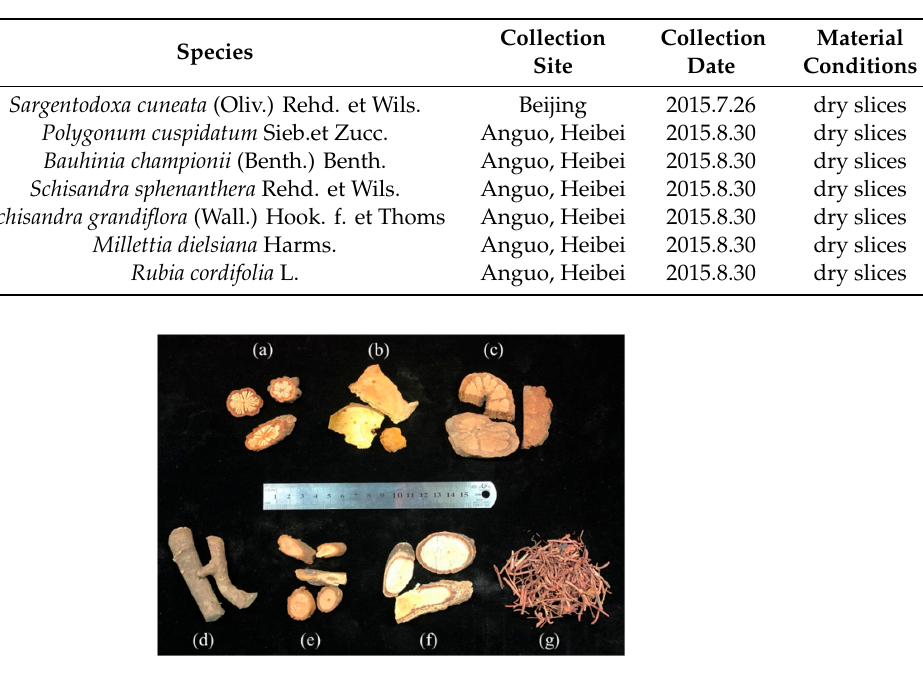
Figure 6. Herb configurations: S. cuneata ( a ), P. cuspidatum ( b ), B. championii ( c ), S. sphenanthera ( d ), S. grandiflora ( e ), M. dielsiana ( f ), and R. cordifolia ( g